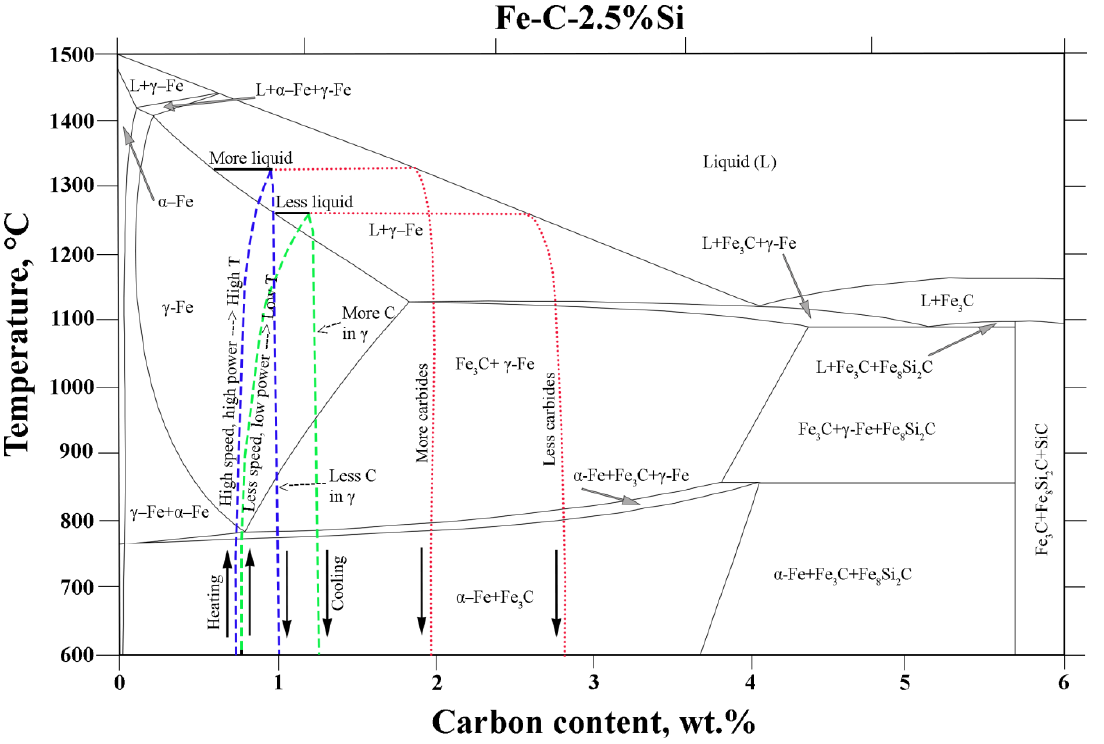
Figure 9. Schematic Fe-C-Si diagram [39].